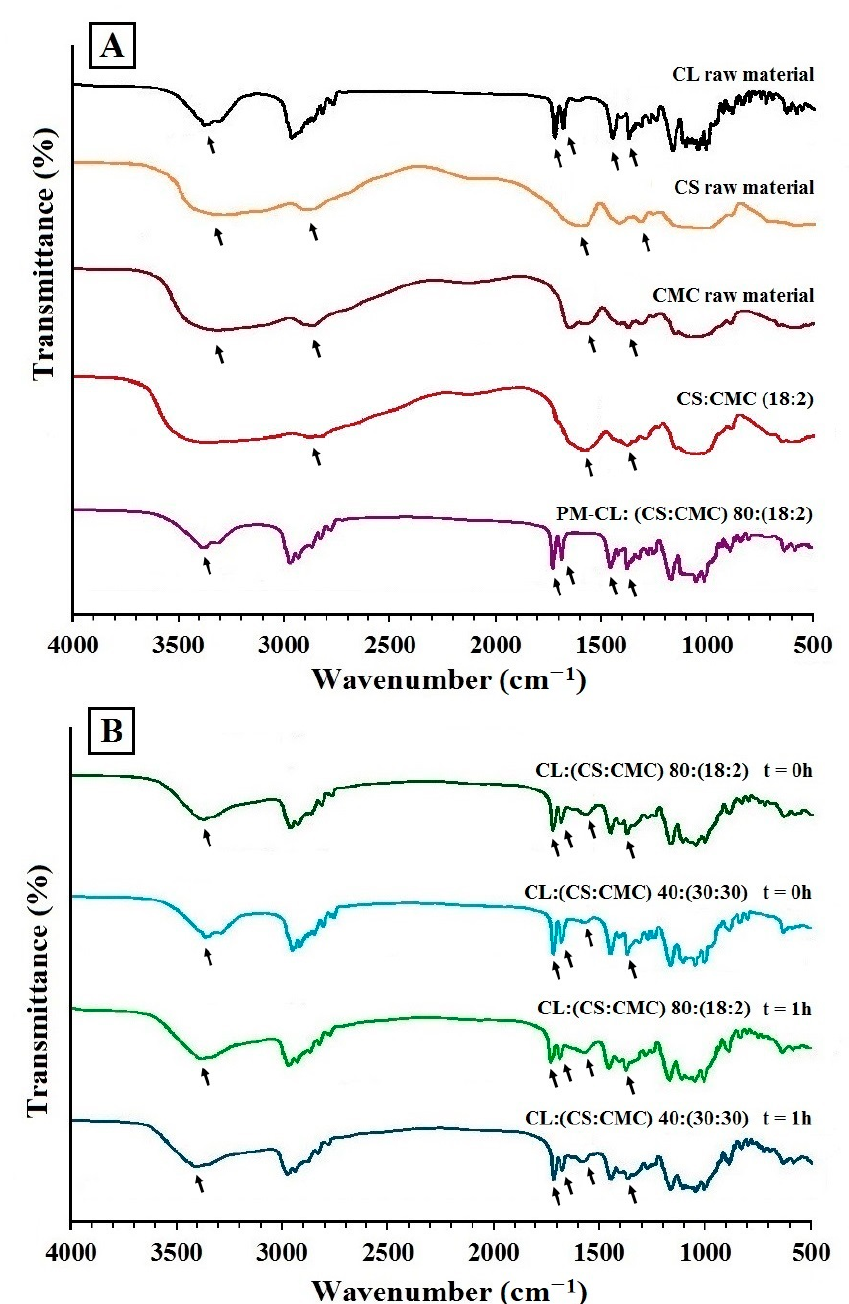
Figure 2. ( A ) TFIR spectrum of clarithromycin (CL), chitosan (CS), carboxymethyl cellulose (CMC), polyelectrolyte complex without clarithromycin CS:CMC (18:2), and physical mixture PM- CL:(CS:CMC) 80:(18:2), physical mixture PM-CL:(CS:CMC) 80:(18:2). ( B ) PEC tablets CL:(CS:CMC) 80:(18:2) and 40:(30:30) at 0 h and after 1 h in the dissolution medium (pH 4.2).